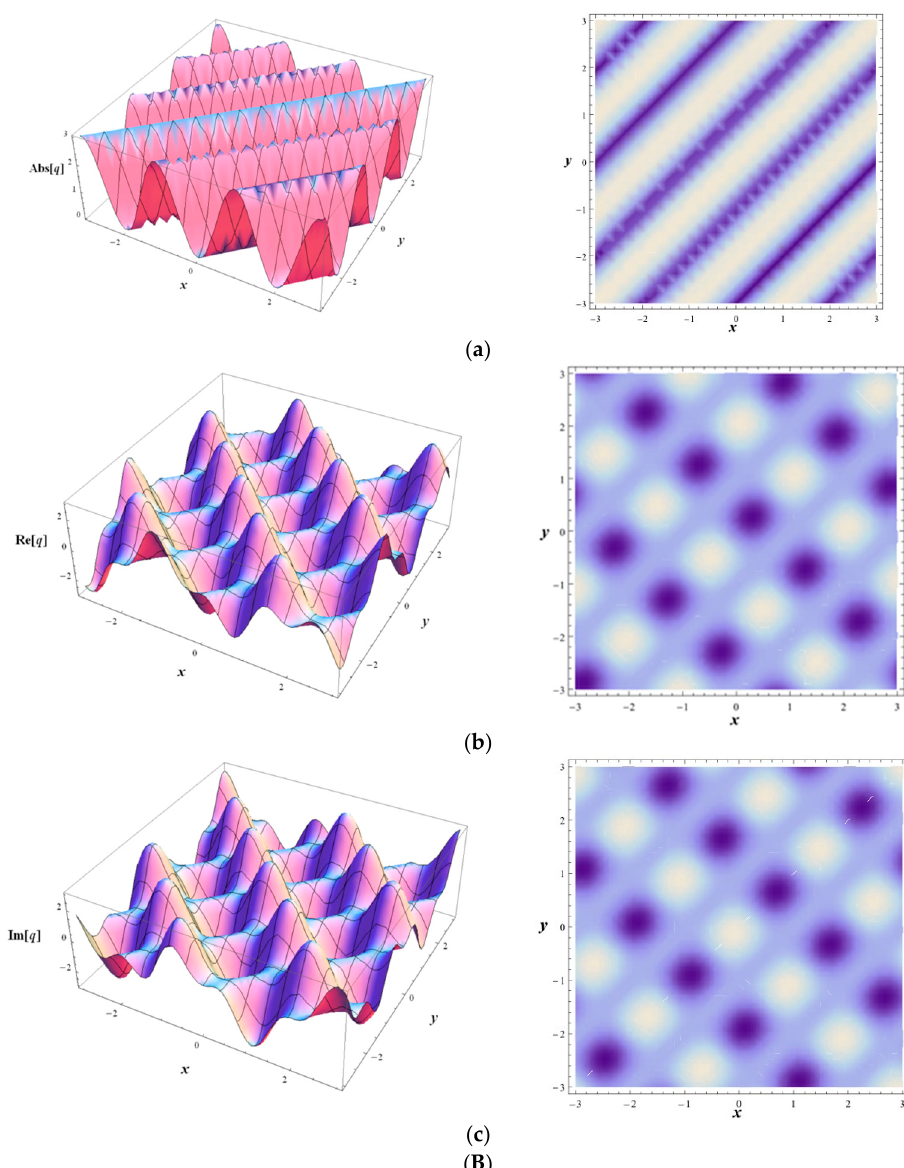
= t . ( A ) The performance of ( ) tyxq ,, . ( Ba )